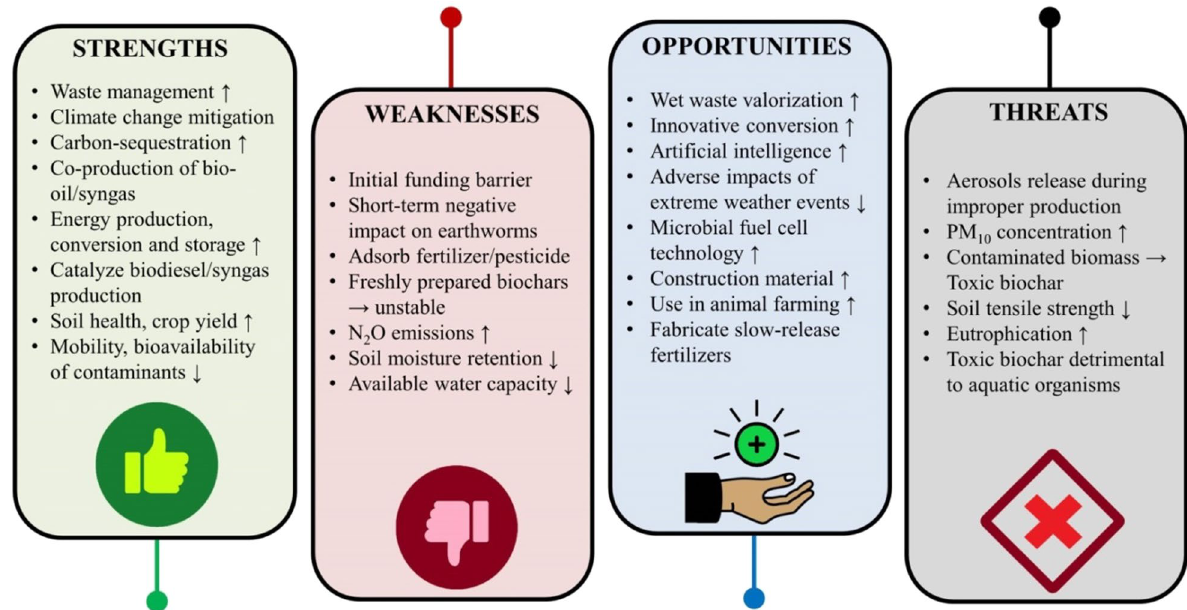
Fig. 10 SWOT analysis of biochar production and its